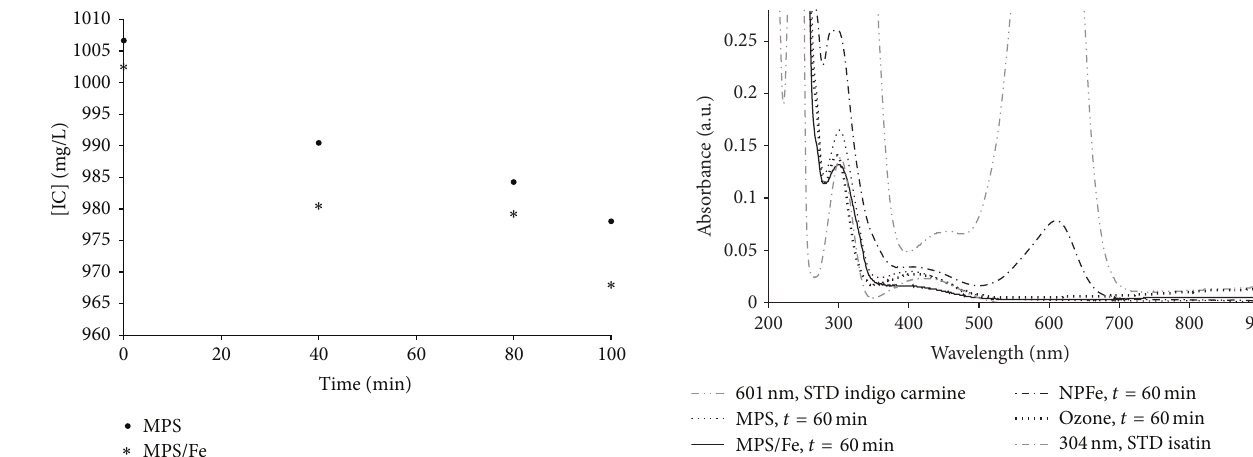
Figure 5: Effect of added material type on the ozonation process on UV-Vis spectra. Reaction time: 60 minutes.